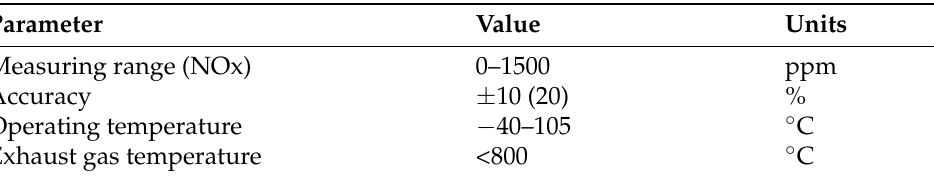
Table 3. Parameters of NOx sensor.